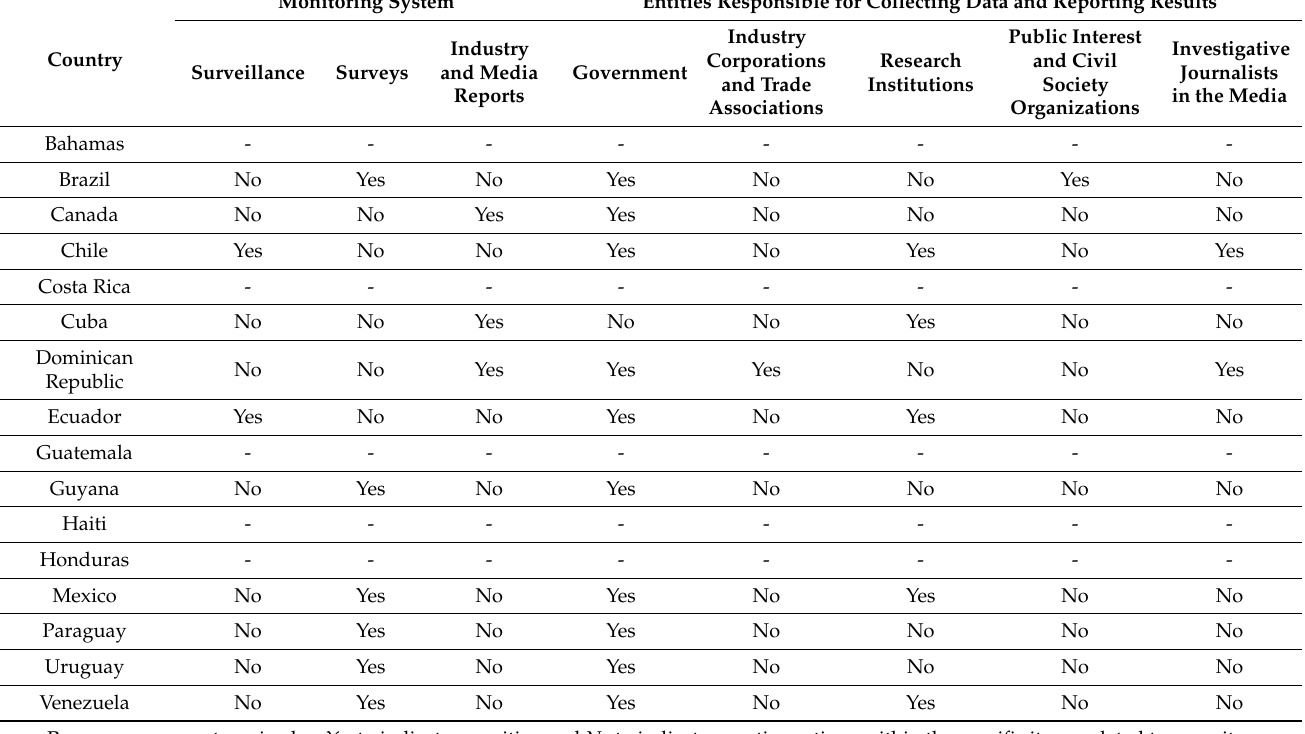
Table 4. Capacity-building information systems to restrict the marketing of HFSS food and non–alcoholic beverages in countries in the region of the